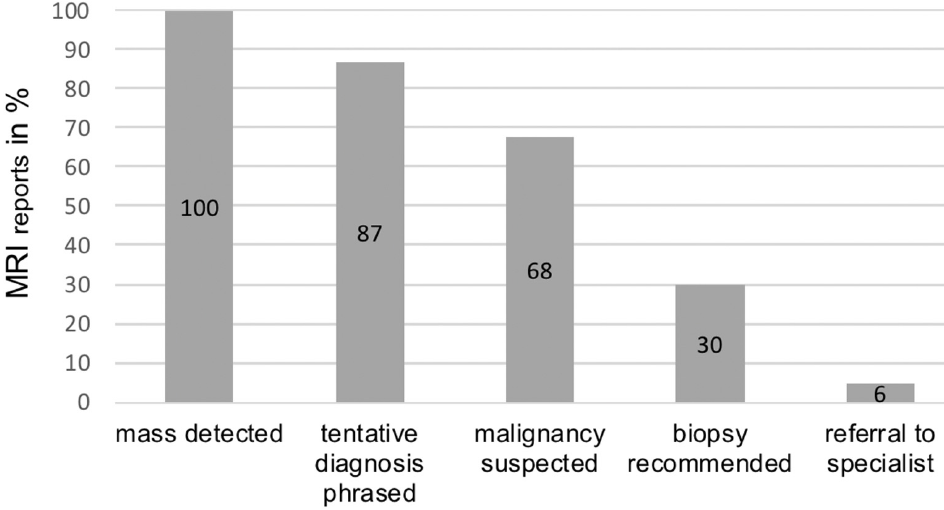
Figure 3. Percentage of MRI reports fulfilling ESSR guideline criteria.